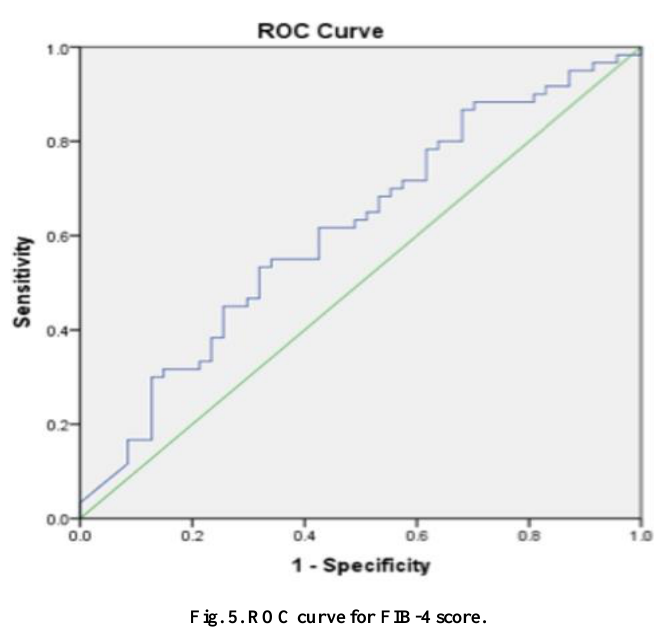
Fig. 5. ROC curve for FIB-4 score.